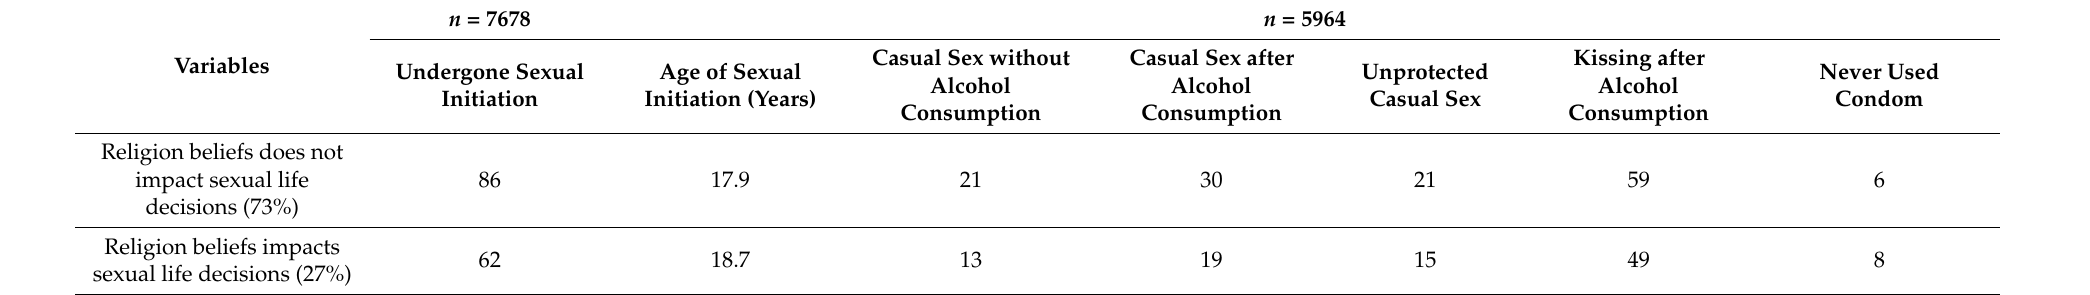
Table 3. Religious impact on sexual life. All data contained in the table are presented as a percentage.